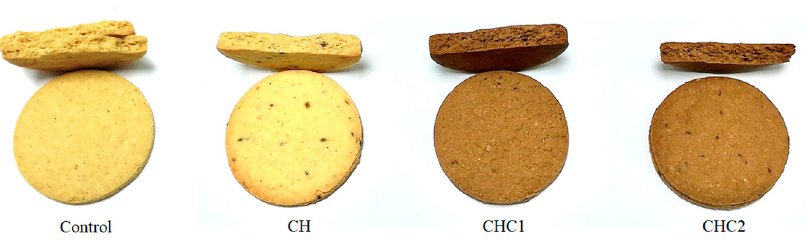
Figure 3. Appearance of developed reduced-fat gluten-free cookies (CH, CH1, CH2) and full-fat cookie (Control). cookie